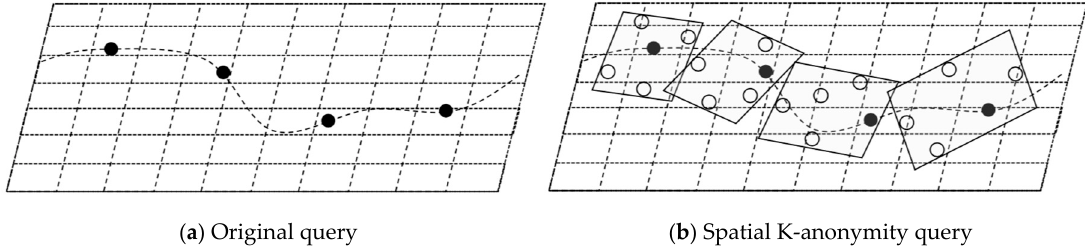
Figure 2. Original query and K-anonymity query of single user.